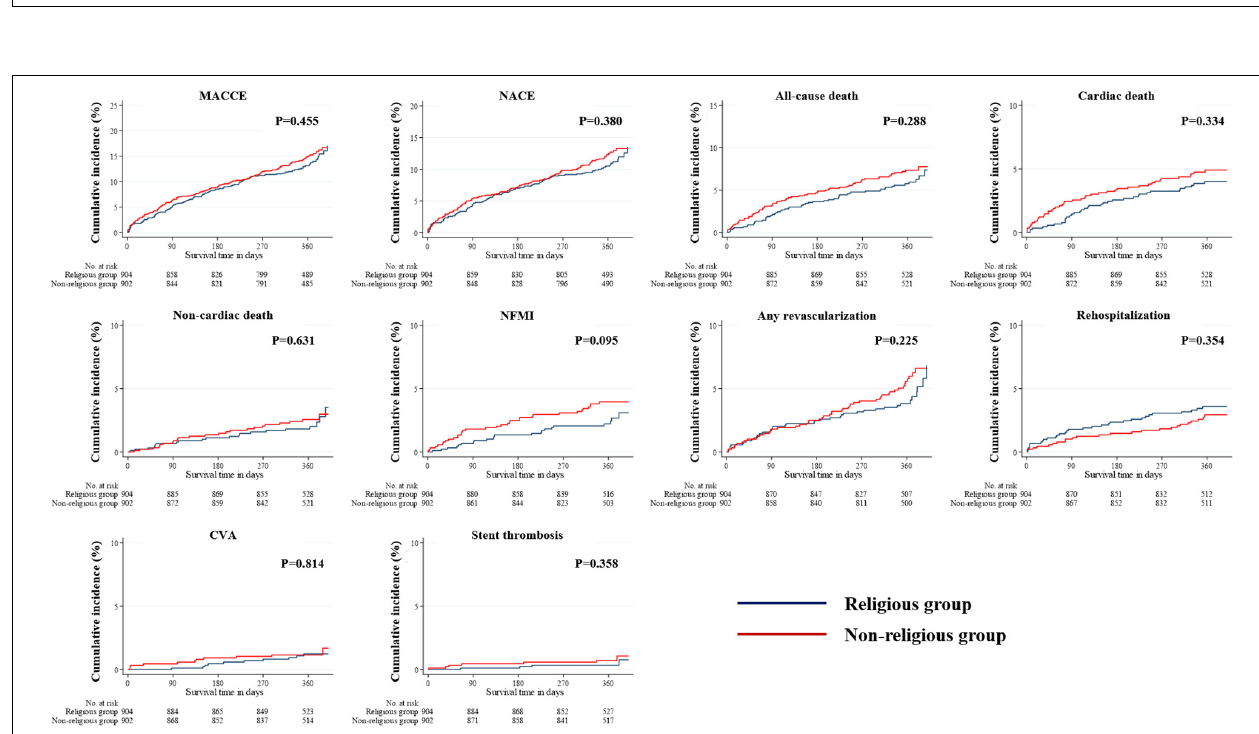
Frontiers in Cardiovascular Medicine |